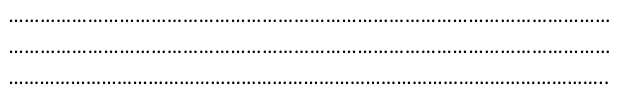
13. Do you considered the drug(s) and/or treatments to be effective in the treatment of Spirocerca lupi ? YES NO If no, specify: